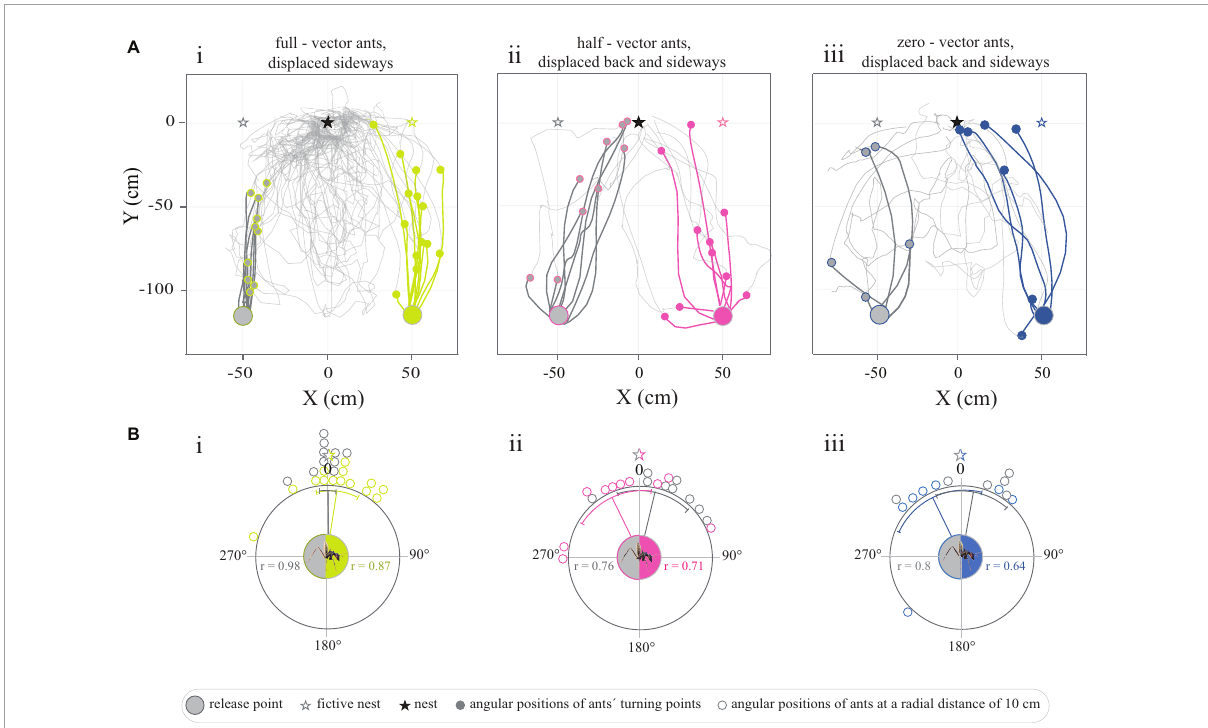
FIGURE4 Tracks of full-vector, half-vector, and zero-vector ants displaced within the vicinity of the nest. (A) Trajectories represent the paths traveled upon the release of ants captured (i) at the feeder (full-vector ants, dark gray-yellow), (ii) midway on their route home (half-vector ants, dark gray-pink), or (iii) just before they entered their nest (zero-vector ants, dark gray-blue). Light gray paths illustrate their search. (Bi–iii) Circular graphs represent the angular positions of ants at a radial distance of 10 cm from the release point in relation to the normalized fictive nest direction (0 ◦ ). Gray and colored lines within the circular graphs indicate mean angles, associated sectors represent the 95% confidence interval of the mean. r represents mean vector